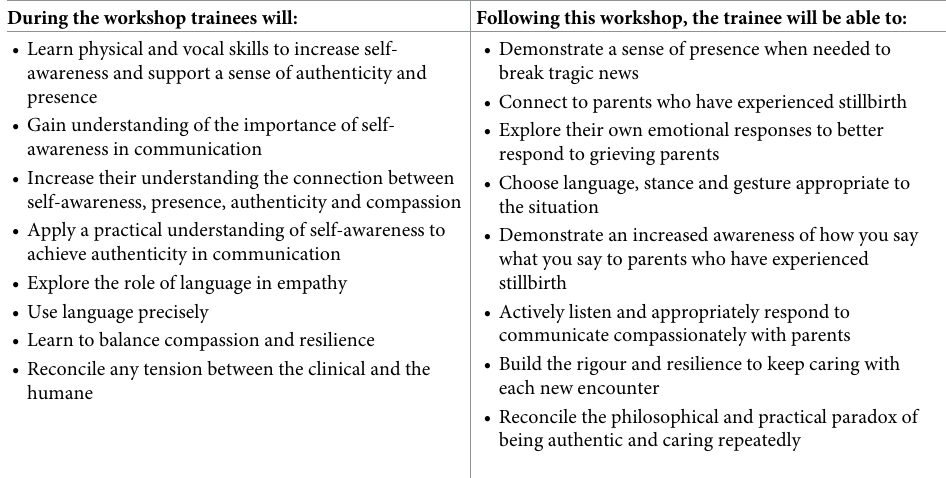
Table 1. Workshop learning aims and